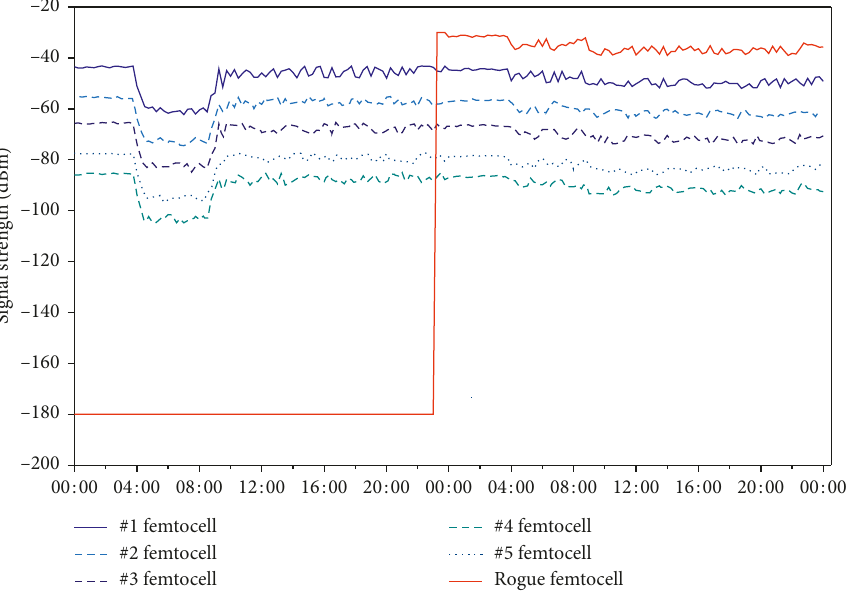
Figure 5: Signal strength profile of stationary rogue and lawful femtocells. Table 1: Euclidean distances of SS between femtocells at